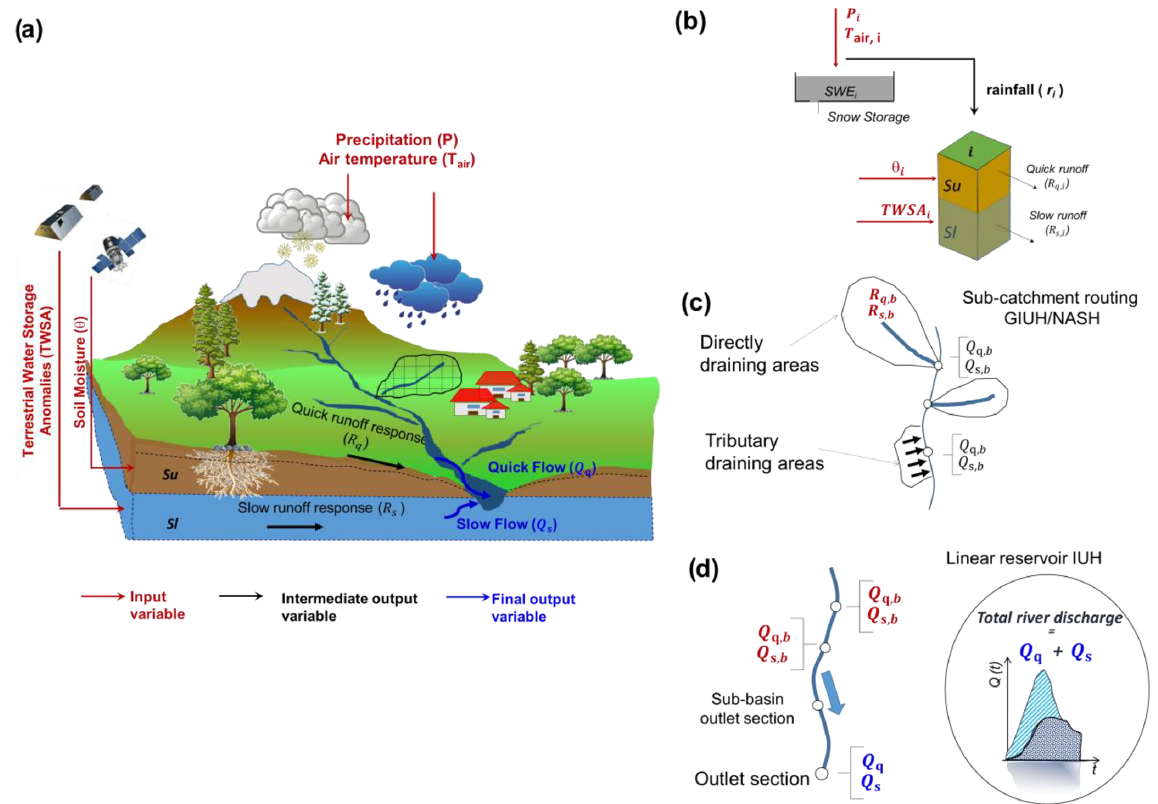
Figure 2. Configuration of the STREAM model adopted for runoff and river discharge estimation. Panel (a) gives an overview of the needed input data and the variables can be obtained as model output. Panel (b) illustrates the runoff generation at cell scale. Panel (c) refers to the sub- catchment river discharge calculation and panel (d) illustrates the river discharge routing through river networks. Red arrows indicate input variables; black arrows indicate intermediate output variables; blue arrows indicate final output variables. Please refer to text for